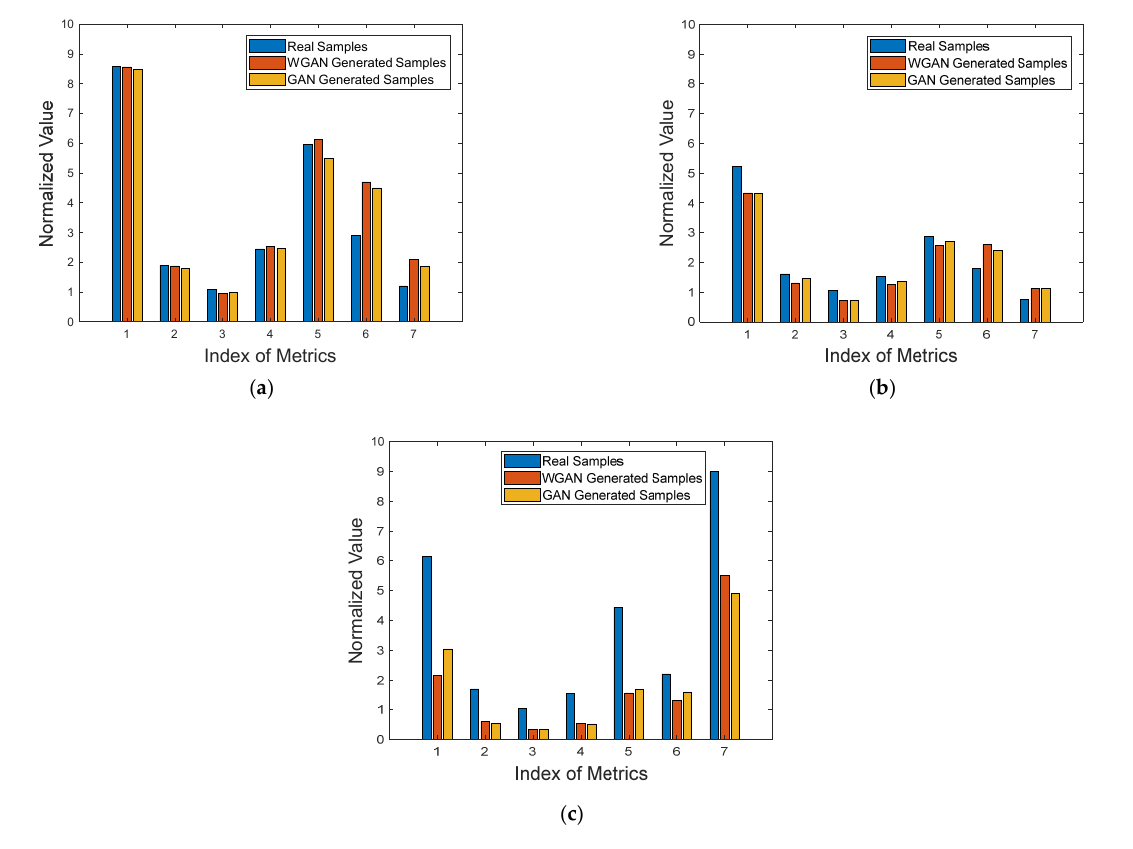
Figure 13. Bar graphs of the seven evaluation metrics of the generated samples from the database obtained from the MOCAP and EM data: ( a ) Walking; ( b ) jumping; ( c ) running. Table 6. Values of the seven evaluation metrics of the generated samples from the measured data.